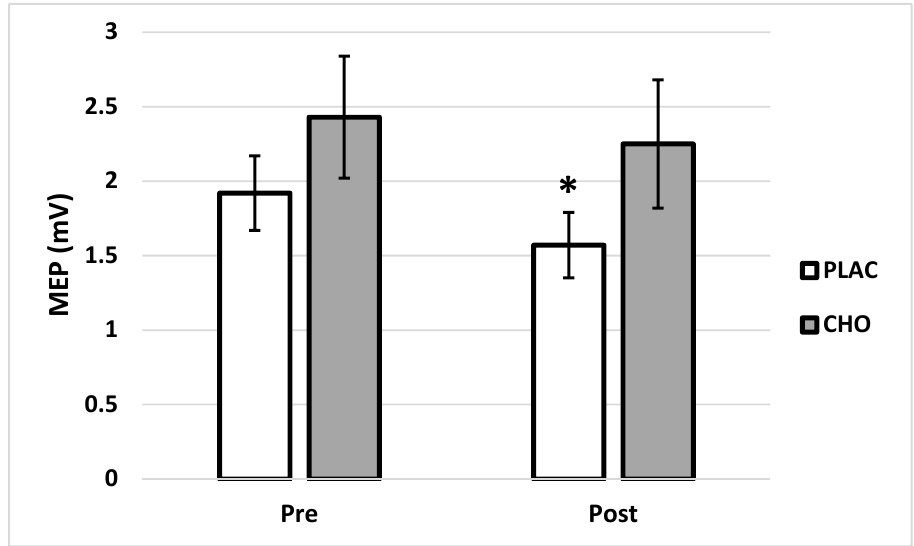
Figure 3. Absolute motor evoked potential (MEP) before and after Stroop Color Word Test (SCWT) when using (PLAC) or carbohydrate (CHO) mouth rinse. * Indicates difference ( p = 0.019) from Pre.